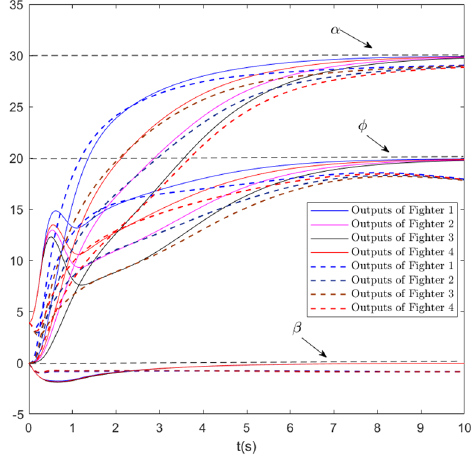
Figure 6. Output of four fighters.